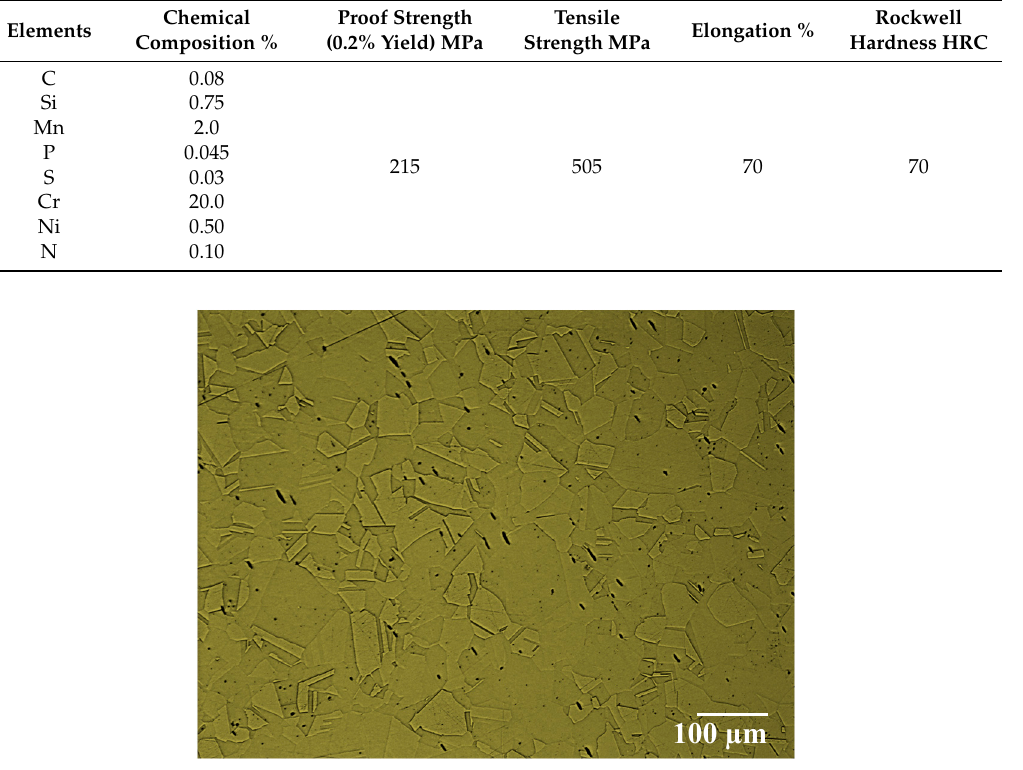
Table 1. Chemical composition and mechanical properties of AISI 304 [29].